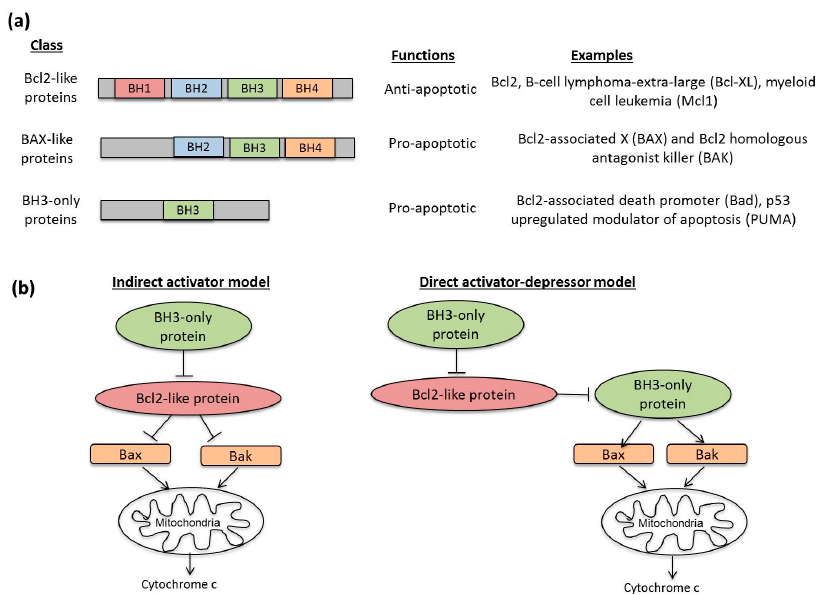
Figure 3. Regulation of MOMP by Bcl2 family of proteins. ( a ) The Bcl2 family of proteins is categorized into three main classes according to their functions and number of Bcl2 homology (BH) domains. The